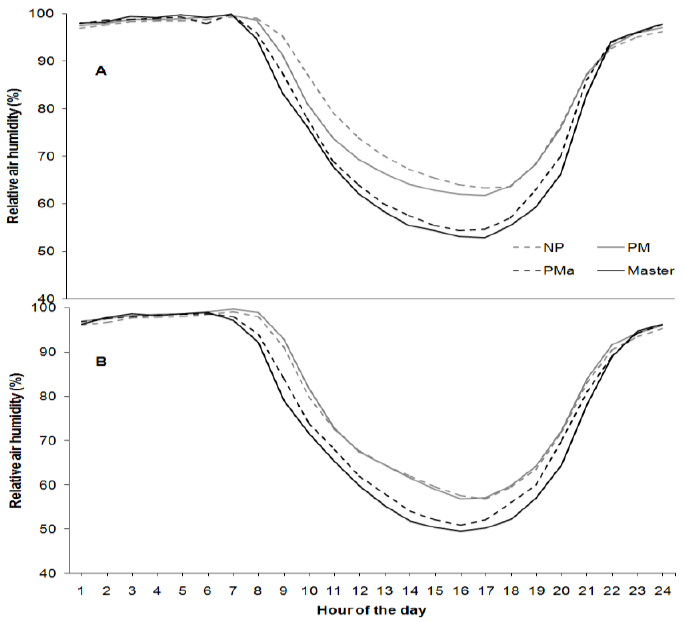
Figure 7. Daily cycle of relative air humidity (%) at the two vineyards (A) (Ponte Piave) and (B) (San Nicolò) in the three field treatments applied: NP, no pruning (gray dotted line); PM mechanical pruning (gray solid line); PMa manual pruning (black dotted line). Master (black solid line) is the relative humidity measured outside the vineyard. All the values are hourly averages of two years of observations from April to